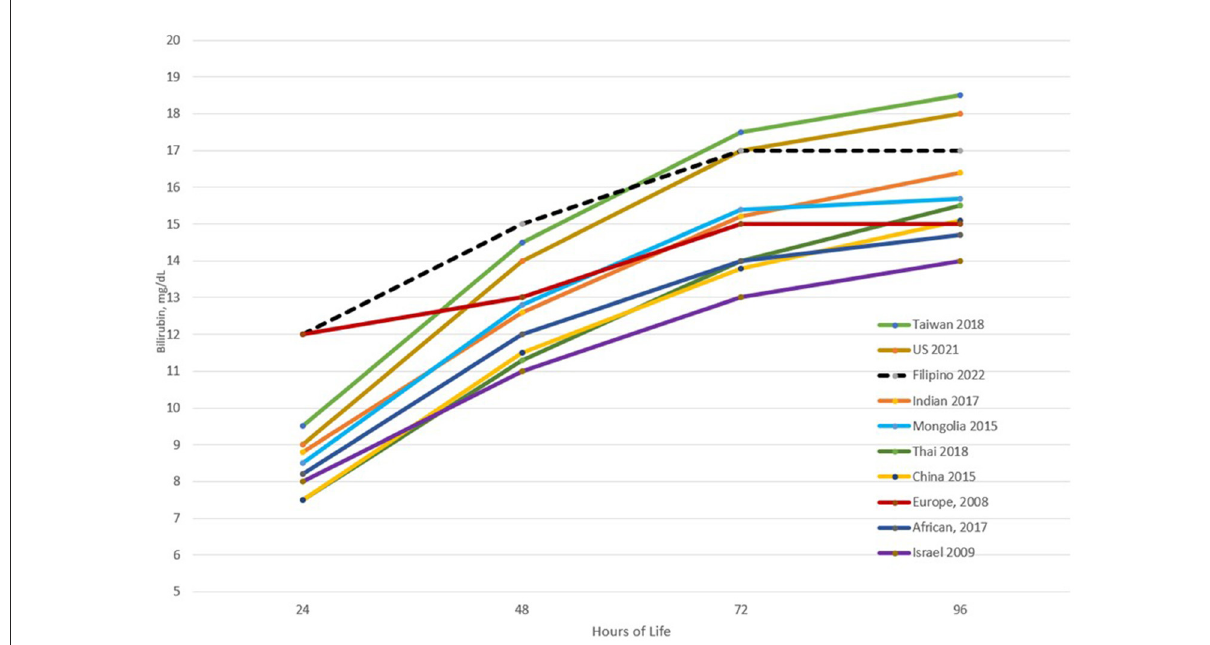
FIGURE5 Comparison of the 95th percentile bilirubin values at different time points across different